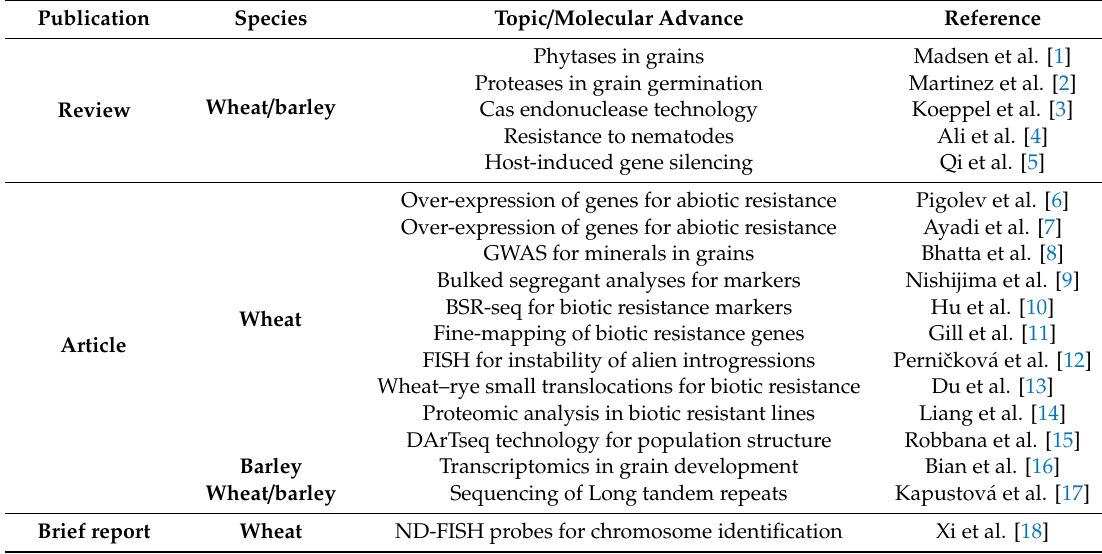
Table 1. Contributors to the Special Issue “Molecular Advances in Wheat and